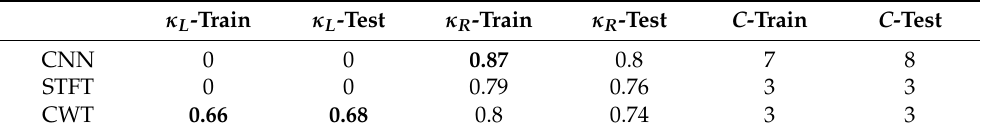
Table 4. Quantitative measures for the seizure dataset. Significantly higher values in a column are in bold (chi-square test). κ indicates the kappa value for SVM; L indicates a linear kernel; R indicates a radial basis function kernel; C indicates the number of clusters by